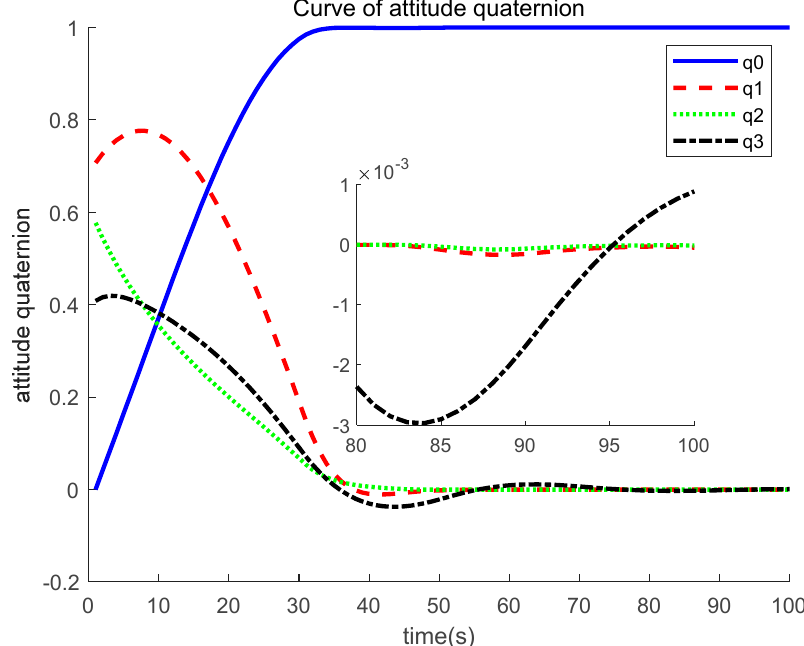
Figure 9. Curve of angular velocity under the controller proposed in this paper with actuator fail- ure.